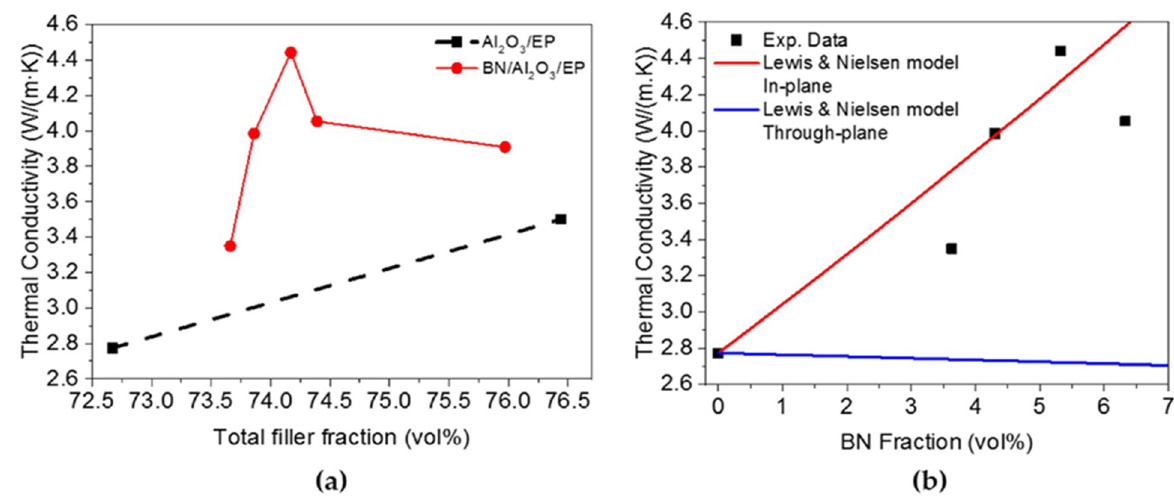
Figure 6. ( a ) Thermal conductivity vs. total filler fraction graph ( b ) Experimental and simulated data comparison graph [61].